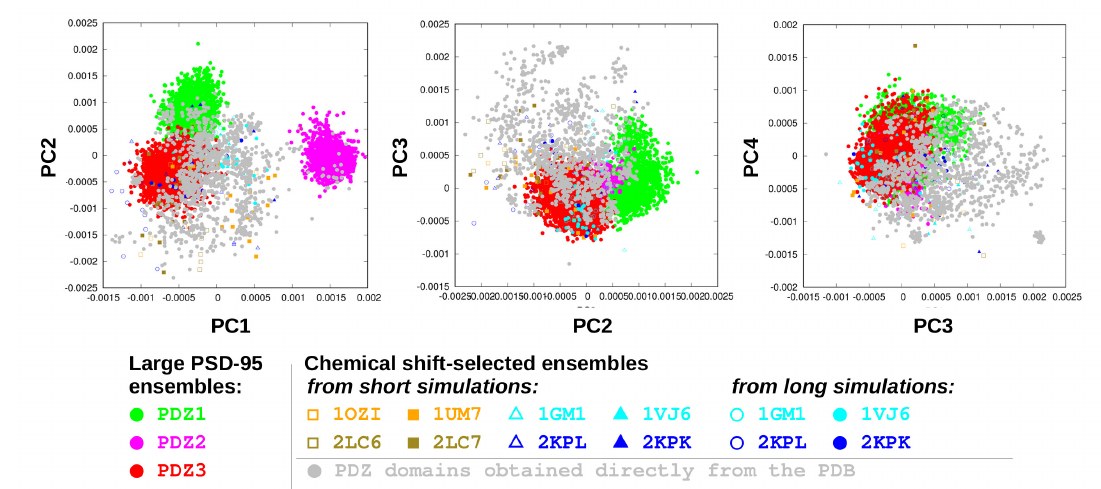
Figure 5. PCA analysis of the extended PDZ domain